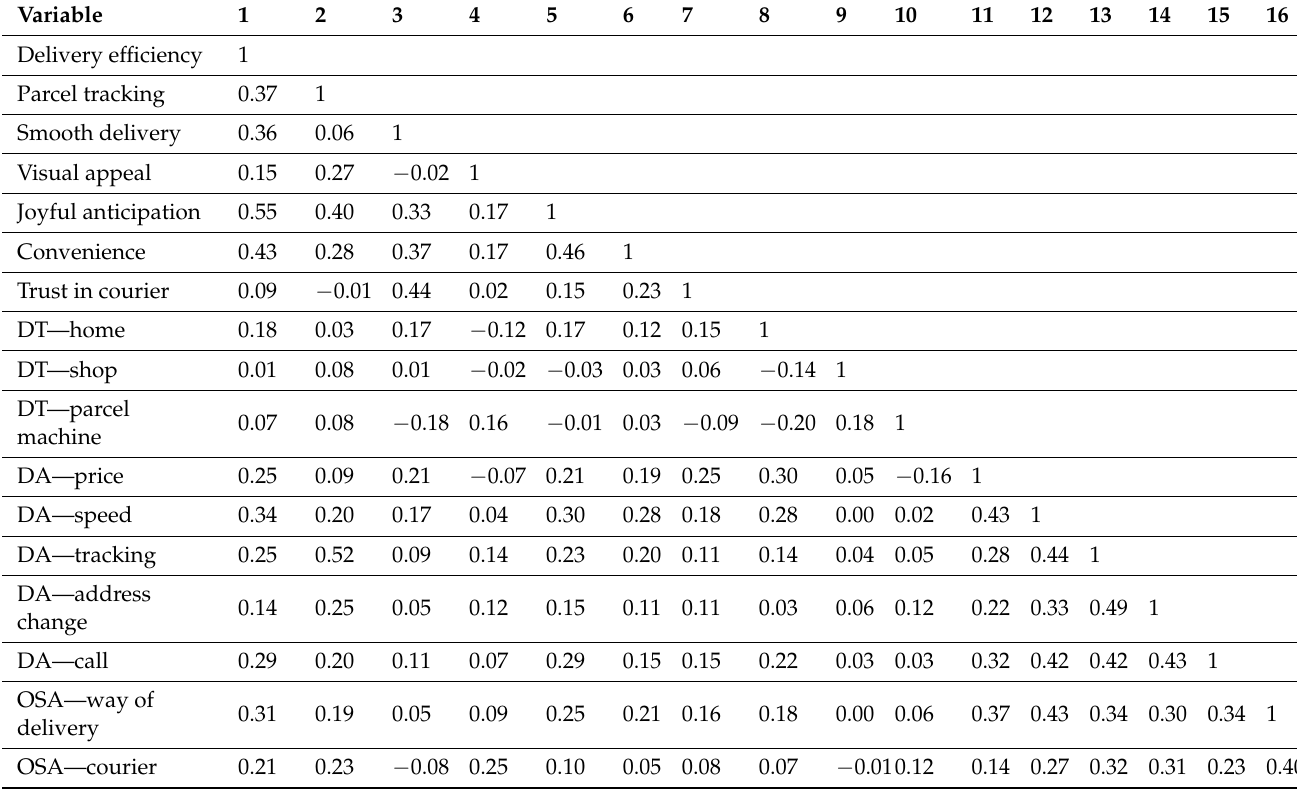
Table 5. Correlations of CDX-LMD scales and other